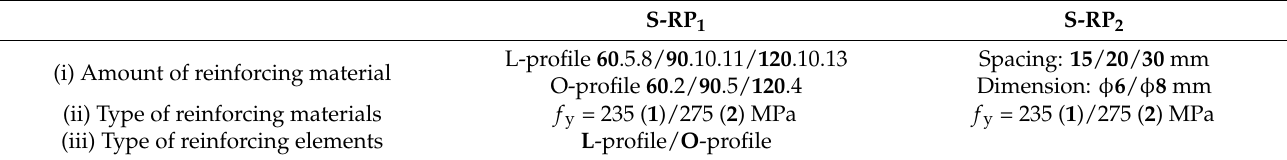
Table 6. Parameters varied in the sensitivity analysis of the seismic